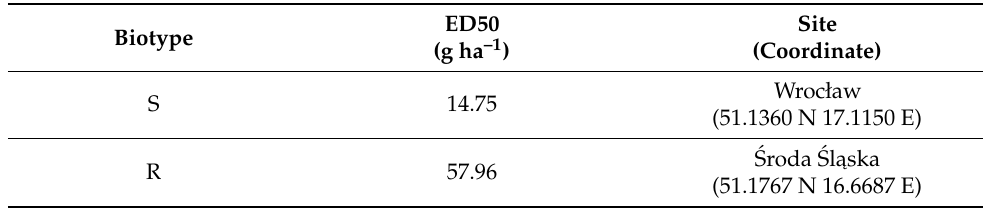
Table 1. Characteristics of herbicide-susceptible (S) and -resistant (R) biotypes of wild oat ( A. fatua ) used in a pot experiment. ED50 values express the effective dose of propoxycarbazone-sodium (HRAC Group 2) causing a 50% reduction in plant biomass (ED50).